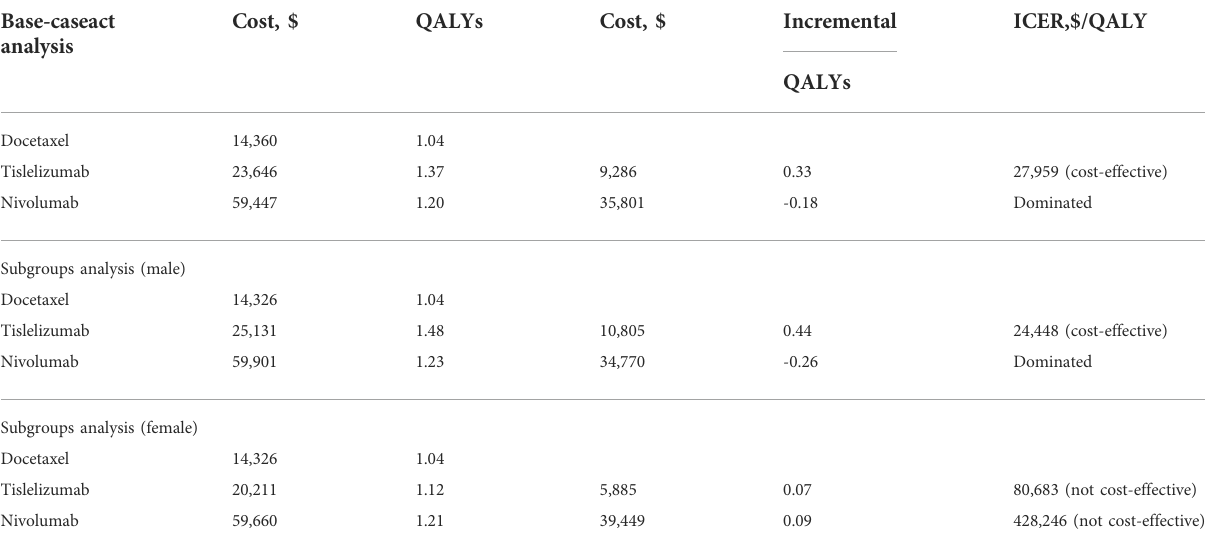
TABLE 2 Summary of simulation